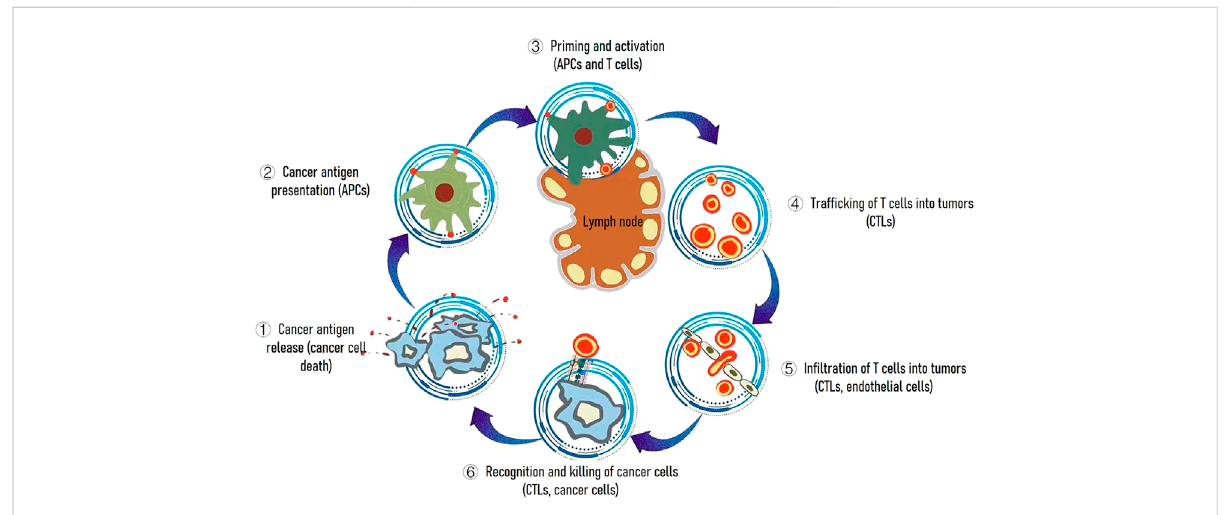
FIGURE 2 The cancer-immunity cycle. The goal of cancer immunotherapy is to initiate or reinitiate a self-sustaining cycle of cancer immunity. Abbreviations are as follows: APCs, antigen presenting cells; CTLs, cytotoxic T lymphocytes.